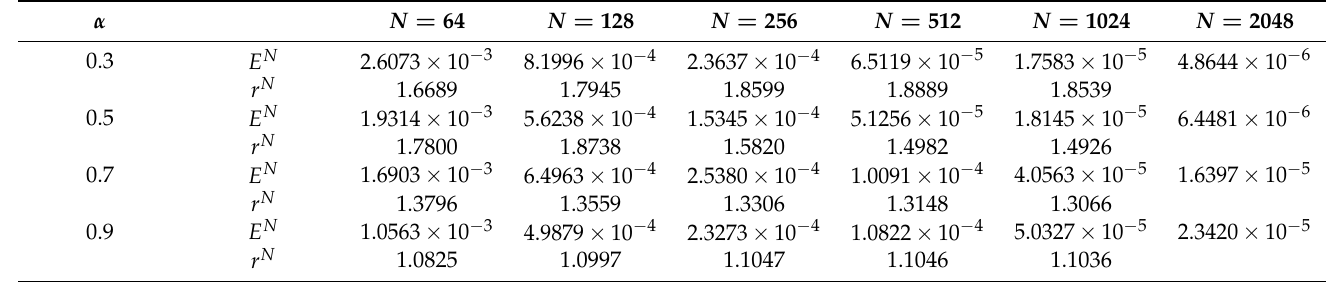
Table 2. Errors and rates of convergence using our new monitor function